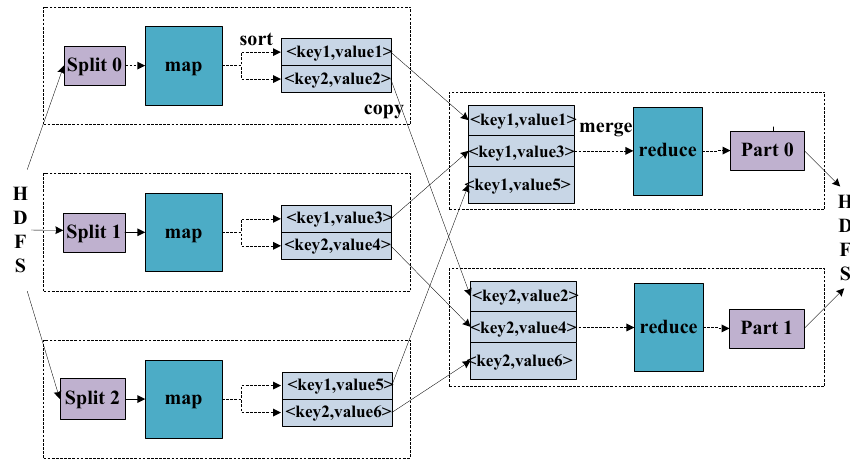
Figure 2. MapReduce model